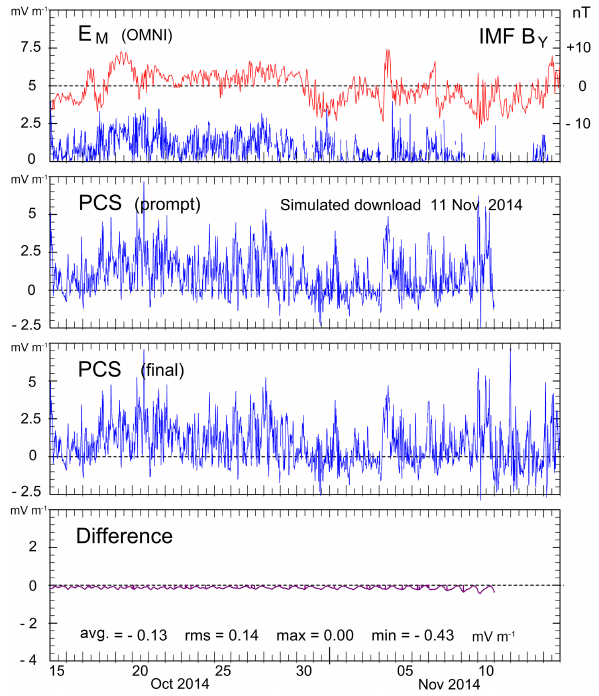
Figure 7. Prompt and final PCS index values based on Vostok data for the dates and in the format of Fig. 5. The E M and IMF B Y data in the top panel are the same as those presented in Fig. 5. The PCS prompt and final indices have been processed from Vostok data by using the “DMI” methods (Stauning,